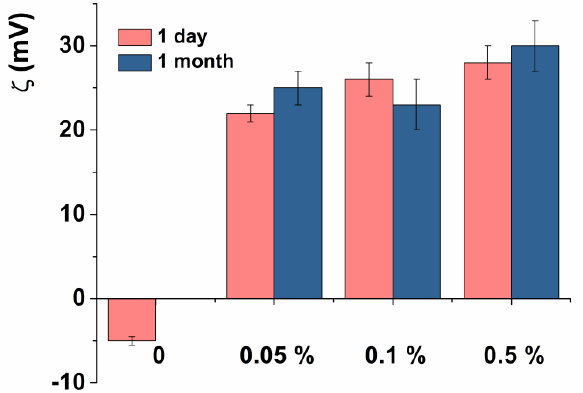
Figure 4. Zeta potential of RhB-loaded chitosomes, modified with various Cs concentrations during storage.